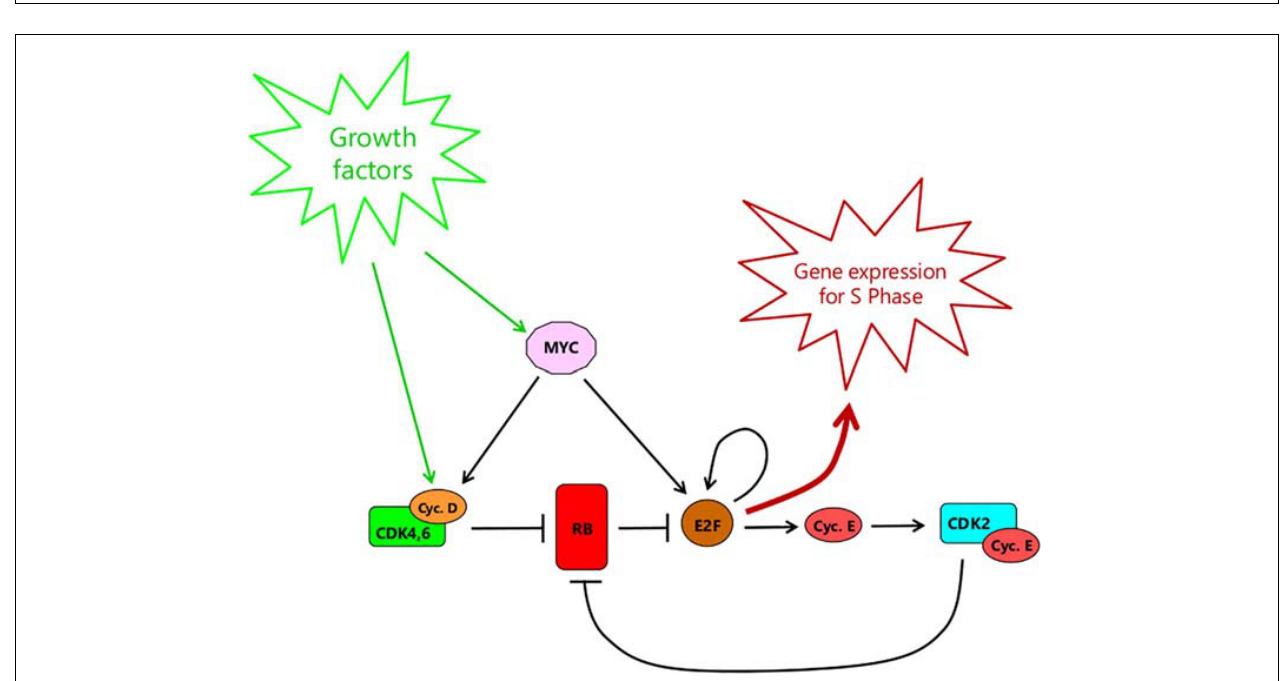
FIGURE 1 | The RB-E2F bistable switch, as outlined by Yao et al. (2008). RB represents the pocket protein family consisting of RB itself, p130 and p107. E2F refers to all activator forms, namely E2F1, E2F2, and E2F3a complexed with a dimerization partner DP1 or DP2. This simplified view of the RB-E2F pathway continues to be useful and conceptually valid. However, see Box 1 for discussion of the distinctive roles of the different RB family members that underlie the pathway.